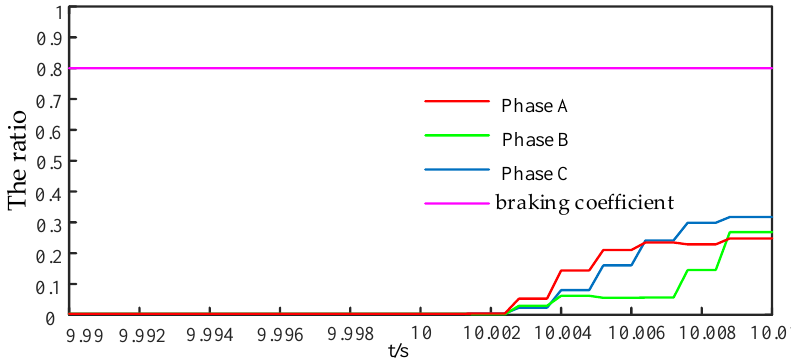
Figure 4. Performance of traditional differential protection for three-phase short circuit.